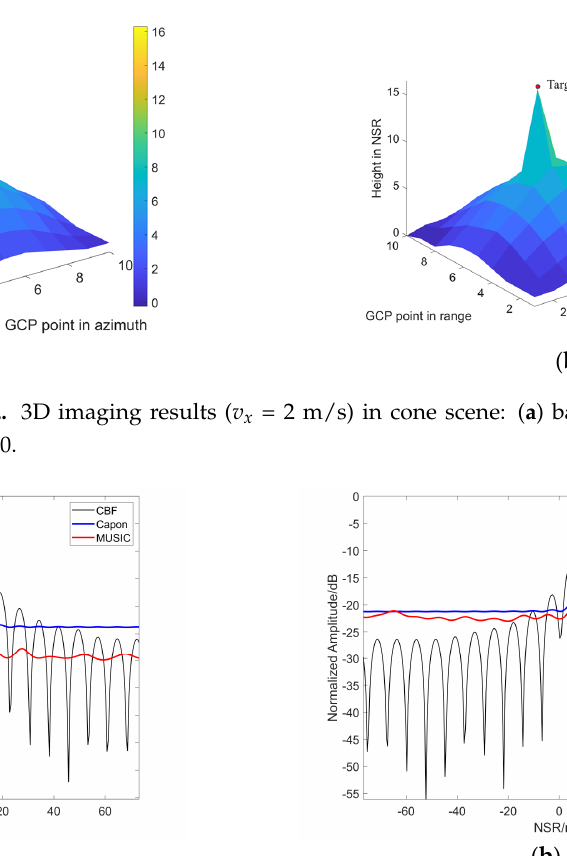
Figure 21. Schematic diagram of the 1st, 2nd, and 3rd in 20 SAR images ( v x = 2 m/s).